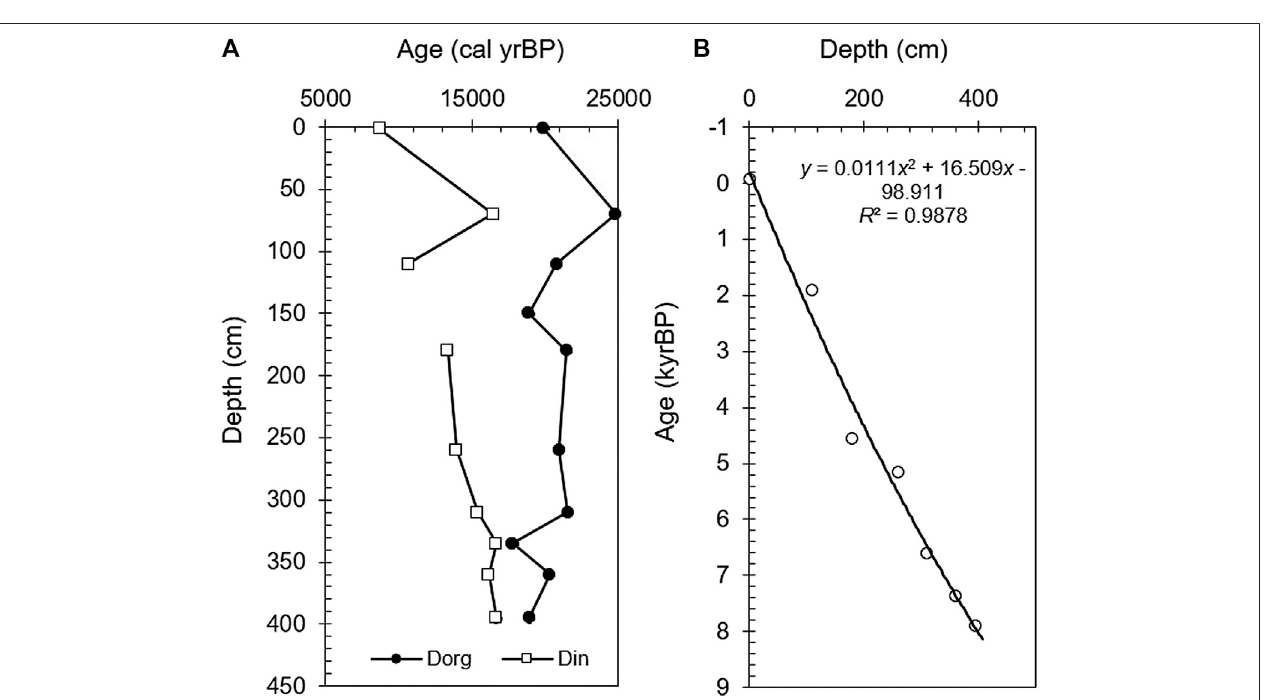
FIGURE 2 | (A) Changes in the bulk organic carbon and inorganic carbon calibrated 14 C dates and inorganic carbon age – depth curves with the authigenic carbonate effect removed. (B) Diagram of age-depth after removing carbon reservoir effect.